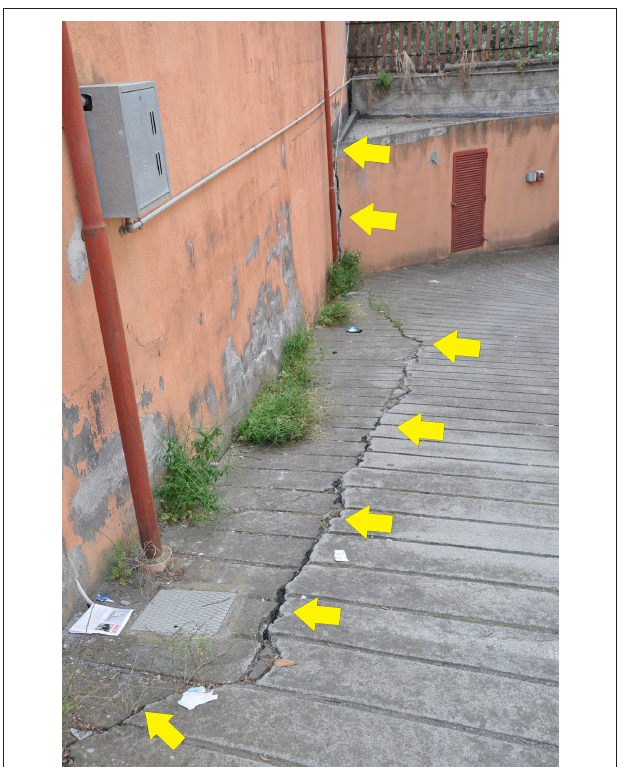
FIGURE 11 | Example of active faulting (indicated by yellow arrows) affecting the urban area of Aci Trezza (see ATF in Figure 1 for location). These fractures constitute a preferential path for the ascent of crustal and sub-crustal gases, including radon, toward the surface and hence into